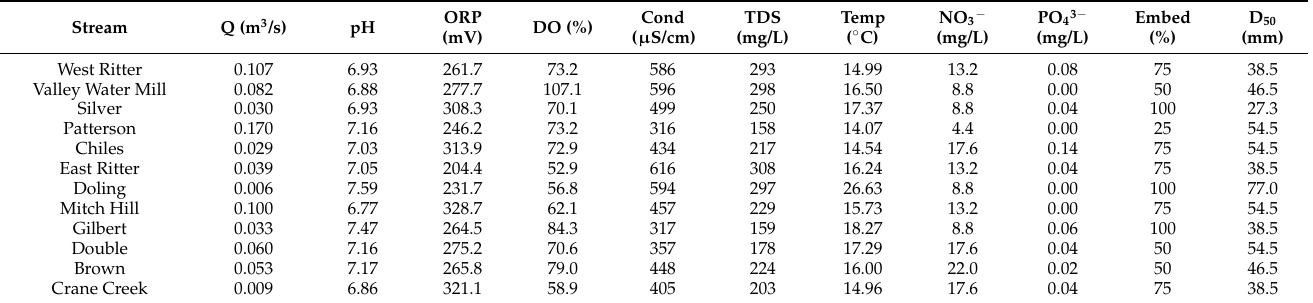
Table 3. Physicochemical variables used in ordination analyses. Variables listed here are discharge (Q), pH, oxidation-reduction potential (ORP), dissolved oxygen percent saturation (DO), specific conductivity (Cond), total dissolved solids (TDS), temperature (Temp), nitrates (NO 3 − ), orthophos- phates (PO 43 − ), embeddedness (Embed), and median substrate size (D 50 ). All measurements are mid-day readings during summer